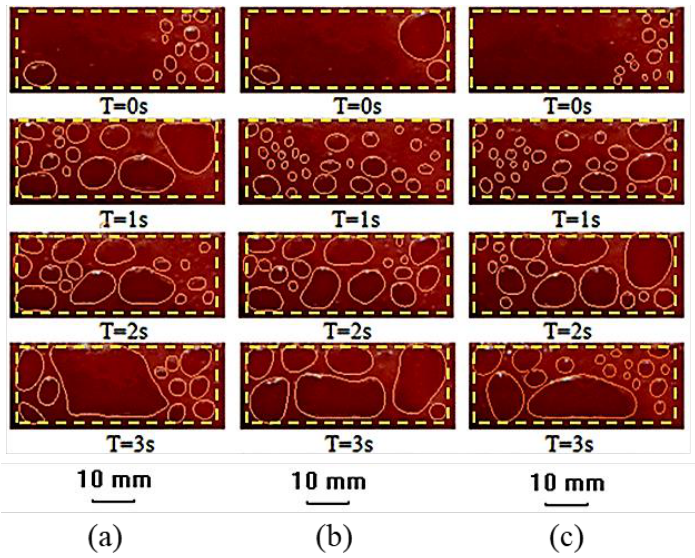
Figure 11. Bubble generation-growth-releasing process on the carbon anode. ( a ) the 1st period; ( b ) the 2nd period; ( c ) the 3rd period.